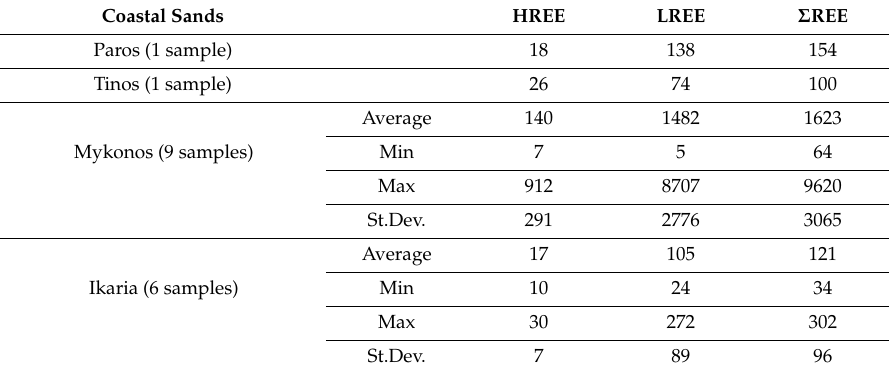
Table S1: REE and trace element concentration of coastal sands from Greece. Detailed geographical and geological maps and archived data as used and displayed in this paper are included in Supplementary